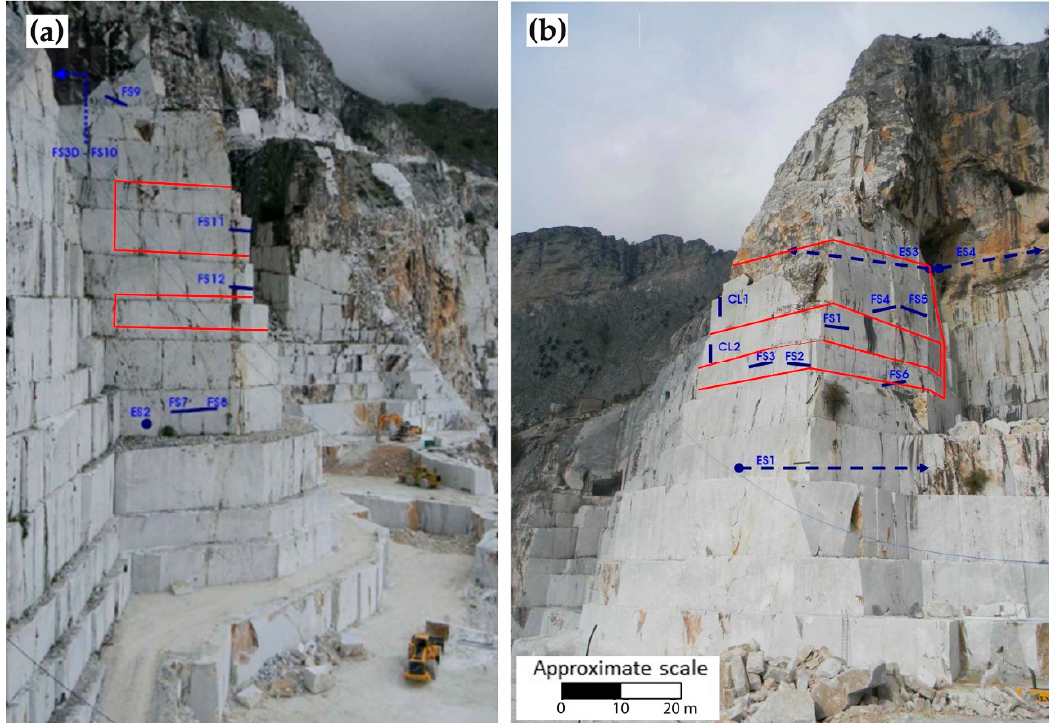
Figure 5. Geotechnical sensors (in blue) and fiber optics cable (in red) on the western (a) and southern-eastern (b) sides of the buttress.